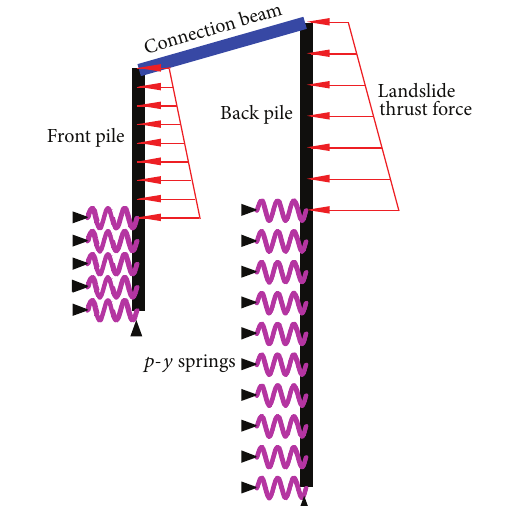
Figure 5: The conceptual calculation model for portal double-row stabilizing pile.